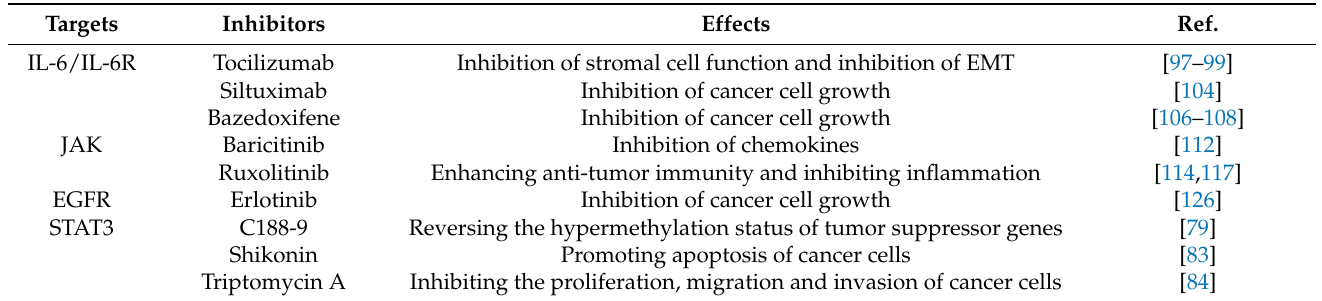
Table 1. Summary of effects of STAT3 target-related inhibitors in pancreatic cancer.